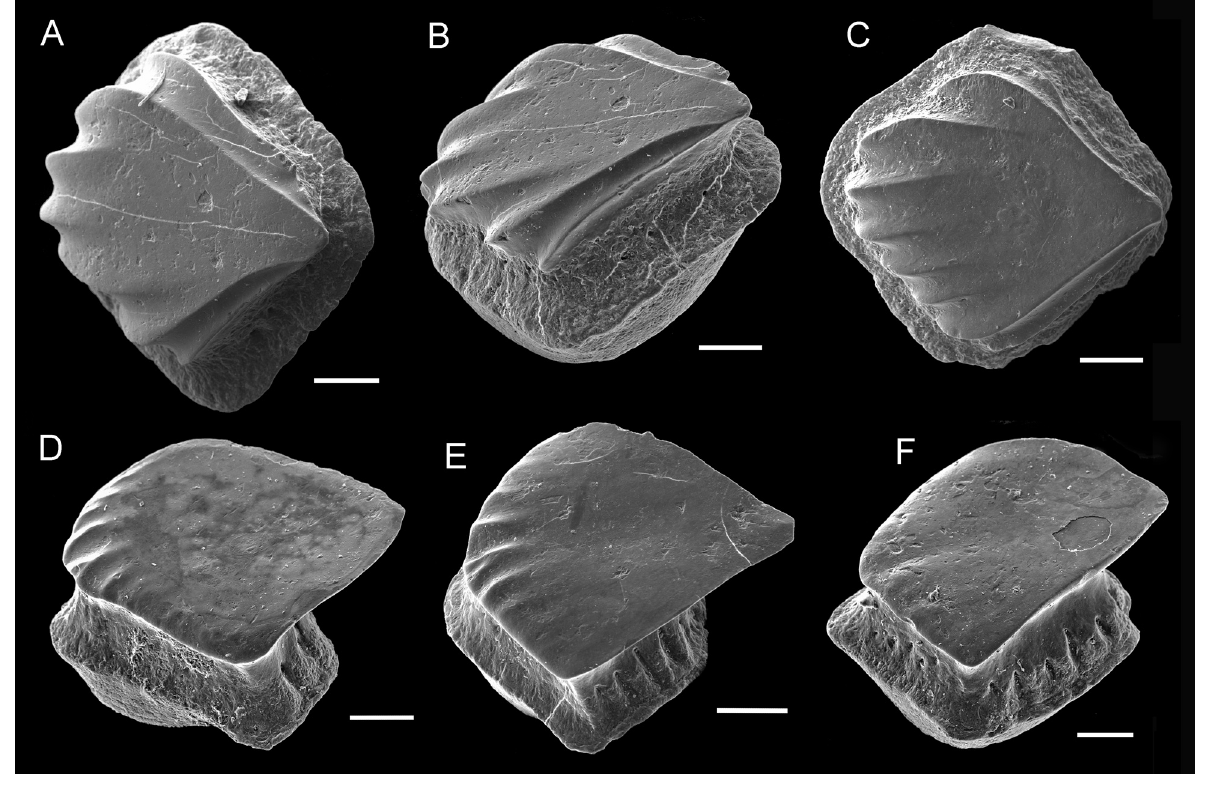
Fig. 2. Scales from profile 2, bed VII, Ohesaare Cliff; Ohesaare Regional Stage. A – C , Nostolepis striata Pander, 1856: A, B, neotype GIT 845-3, in crown and laterocrown views; C, GIT 845-6, asymmetric scale with narrow side crown ledge; D – F , Gomphonchus sandelensis (Pander, 1856): D, neotype GIT 845-14, scale with short weak ridges along anterior crown edge, in laterocrown view; E, GIT 845-11, scale similar to the neotype; F, GIT 845-13, scale with almost smooth crown. Scale bars = 0.1 mm. Anterior is to the